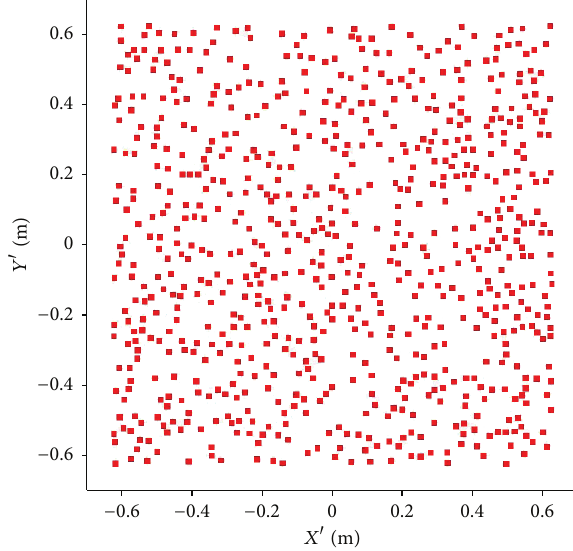
Figure 3: Overview of the passive reflecting surfaces (PRS). The variables 𝑋 󸀠 and 𝑌 󸀠 , expressed in meters, are relative to the center of the